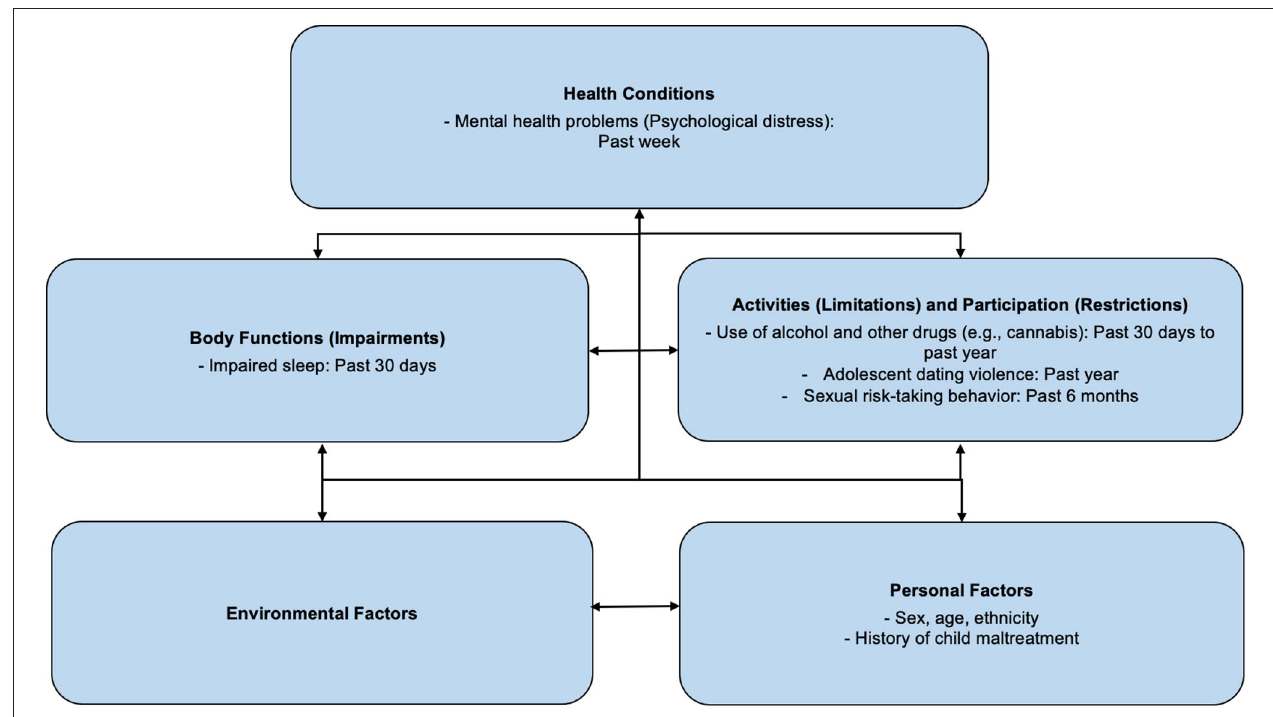
FIGURE 1 | Distal ICF factors: Sexual risk-taking behaviours include early sexual debut, multiple sexual partners historically, a pattern of unprotected intercourse, or sex while under the influence of alcohol or drugs. These may result in negative personal health implications ( 71). Impaired sleep refers to the presence of difficulty with sleep, which could present itself as sleep onset latency, frequent nocturnal awakenings, or prolonged periods of wakefulness during the sleep period ( 72).